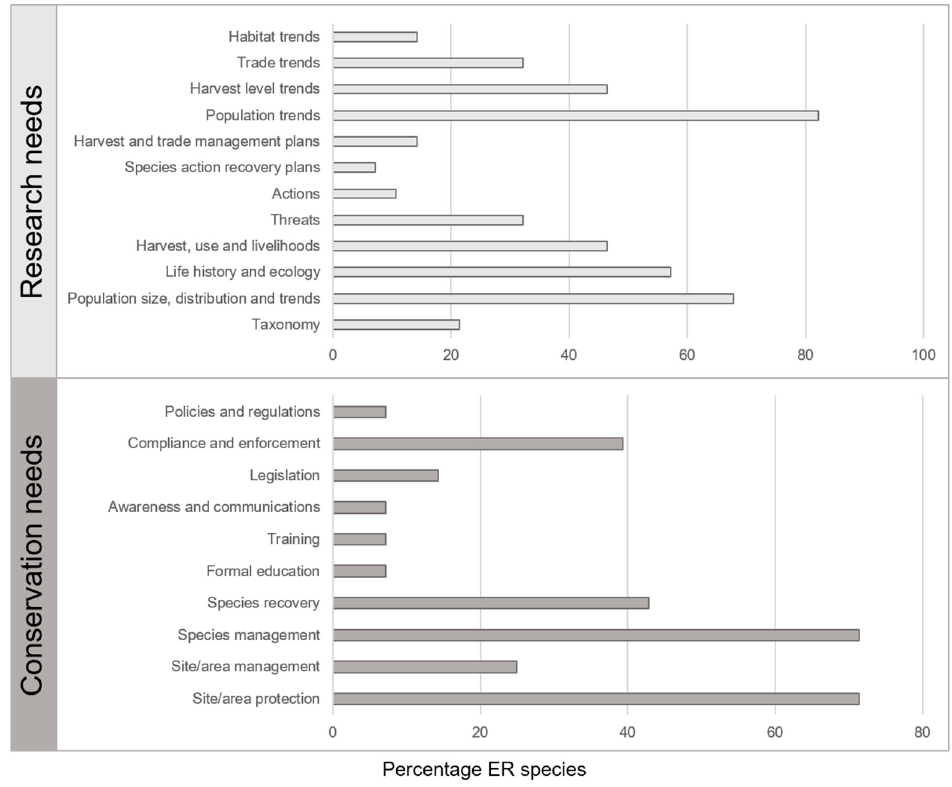
Figure 3. Listed research and conservation needs for all ER species, presented as percentage of species requiring a particular research or conservation action.